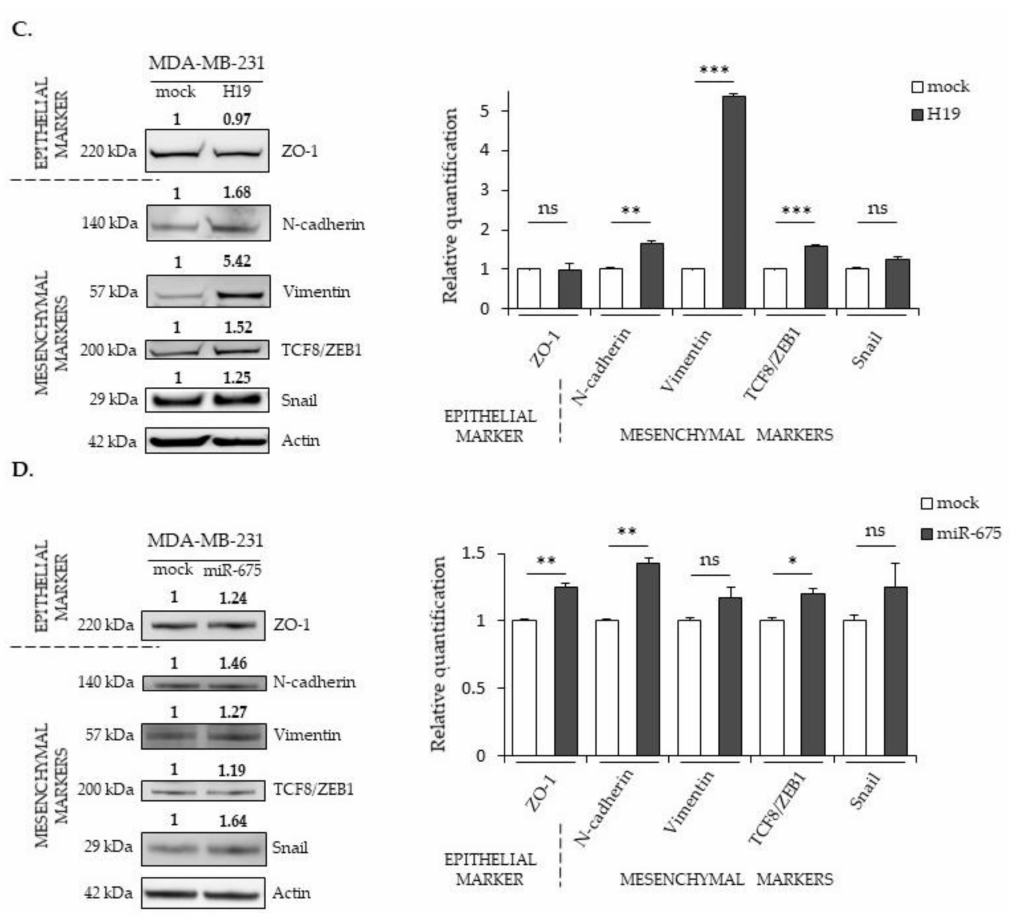
Figure 4. The e ff ects of H19 and miR-675 on the expressions of the epithelial-to-mesenchymal transition (EMT) markers. (A) EMT protein expressions in the MCF-7 control (mock) or H19 -stably overexpressing cells (H19), determined by Western blot analysis. (B) EMT protein expressions in SUM159PT-pH19-mCherry neg (mCherry neg ) or SUM159PT-pH19-mCherry high (mCherry high ), determined by Western blot analysis. (C) EMT protein expressions in the MDA-MB-231 control (mock) or H19 -stably overexpressing cells (H19), determined by Western blot analysis. (D) EMT protein expressions in the MDA-MB-231 control (mock) or miR-675-stably overexpressing cells (miR-675), determined by Western blot analysis. For each panel, actin was used as the equi-loading control. The relative signal intensities were quantified by ImageJ and shown above the protein bands for the representative experiment figure. The quantification of the triplicate is figured in the graph beside. * p < 0.05; ** p < 0.01; *** p < 0.001; ns: not significant. Uncropped blots are shown in Figures